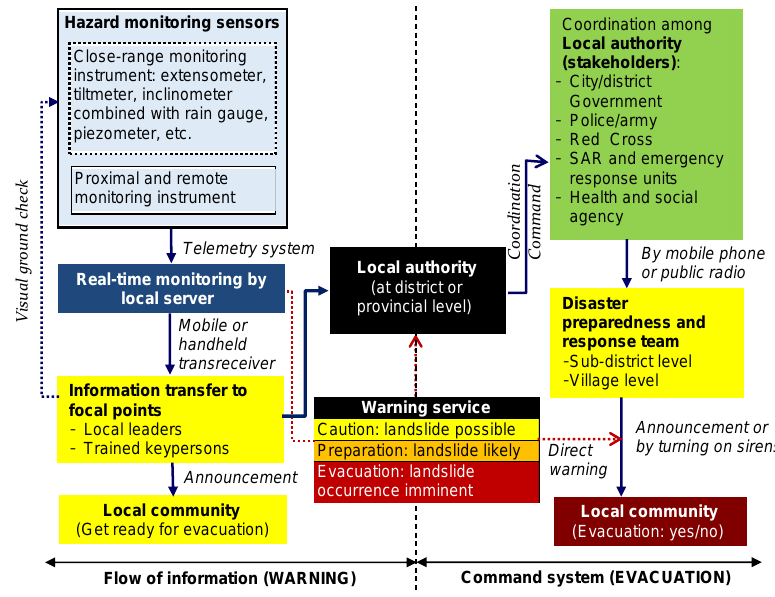
Figure 7: Flow of information and command system for landslide early warning systems (after Fathani et al., 2014).